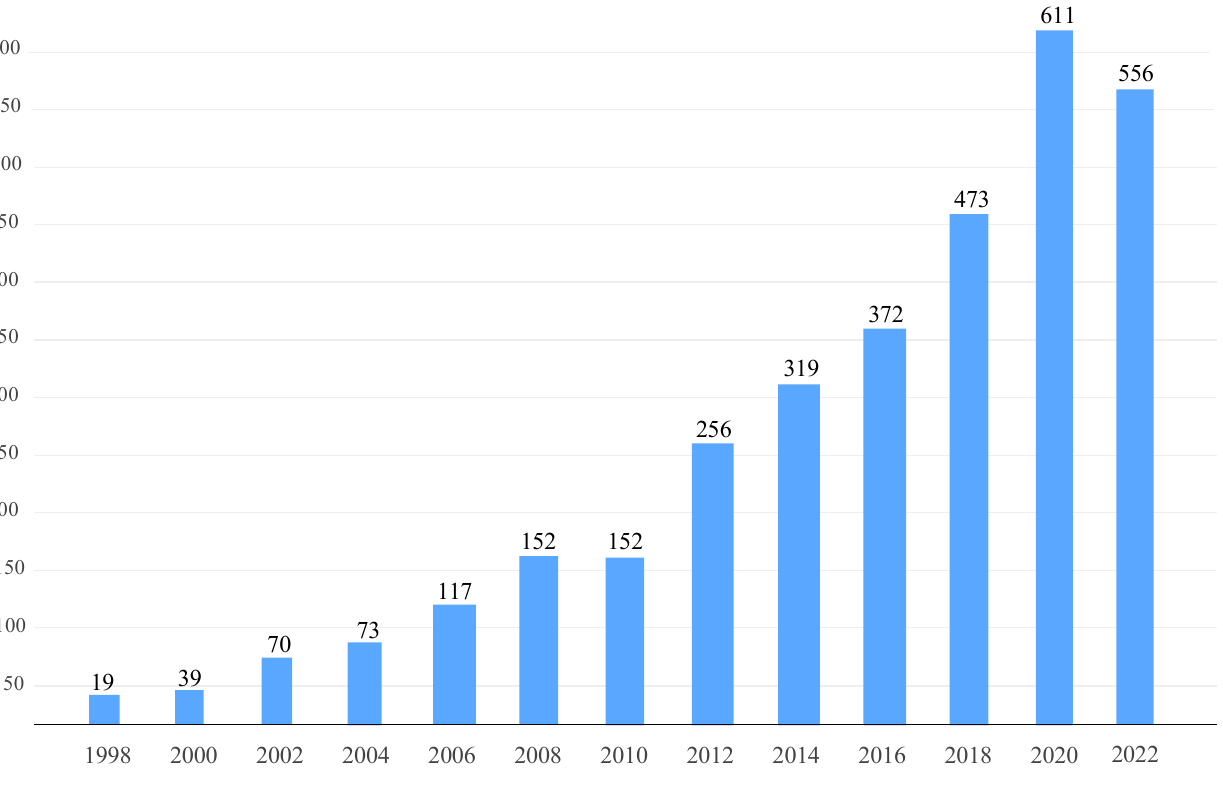
Figure 2. Recent burgeoning in CA-based articles in peer-reviewed journals. Compact development is one of the most ideal urban forms in terms of land devel- opment proximity and clustering [61]. The majority of urban planners and scholars are concerned with the changing shape and size of built-up regions, rather than physical charac- teristics like density and open space. The total number of people that can be accommodated by a developed cell, also known as urban densification, can be expressed by development density. In an urban CA model, transition rules can be designed with urban densities as a simulation account. If the density factor is taken into account, the chance of development should be proportional to the total density of development (people) in the area. CA models may accommodate a wide range of urban change processes that recognize the